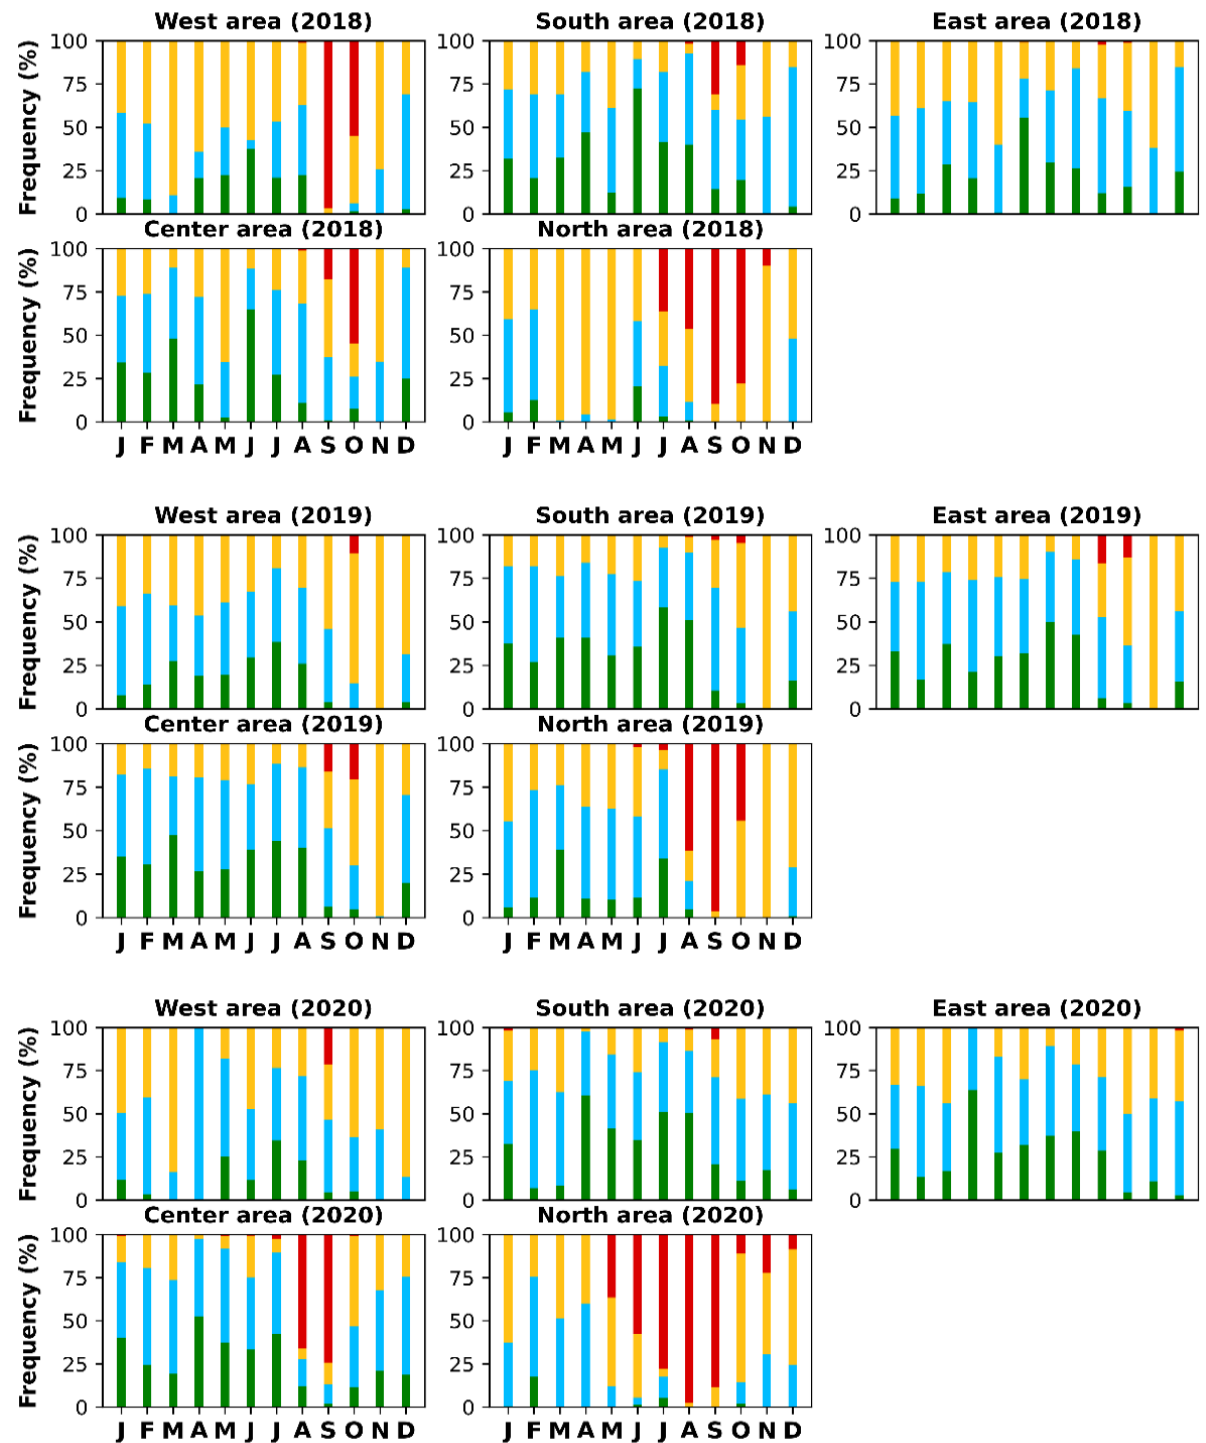
Figure 12. Monthly frequency (%) of each of the OWTs in the five areas of the reservoir, and for the 4 years analyzed. The green bars represent OWT1, in blue the OWT2, in orange the OWT3, and red is OWT4.